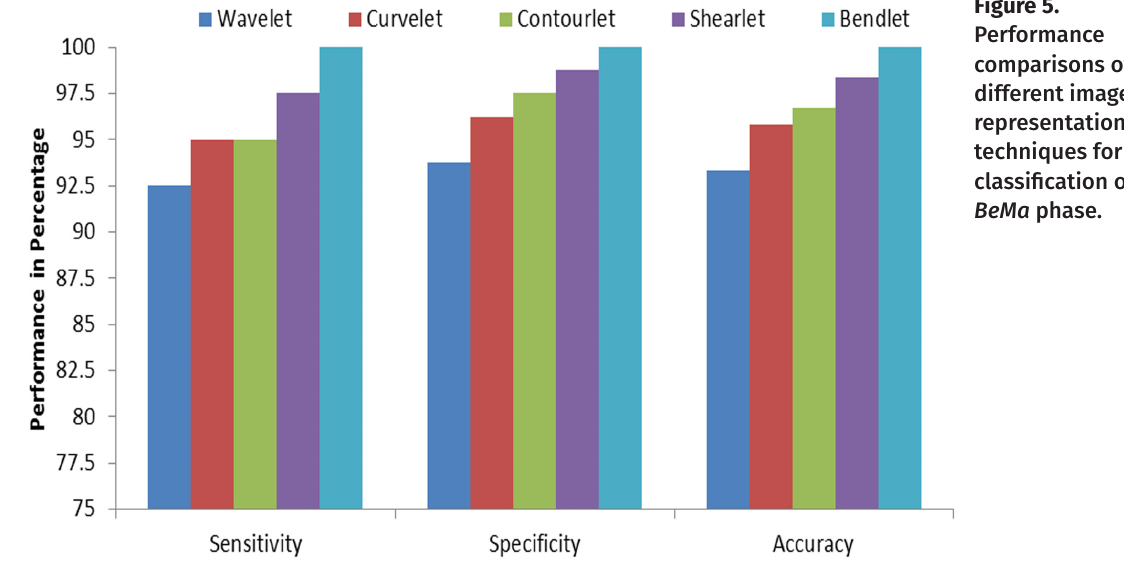
Figure 5. Performance comparisons of different image representation techniques for the classification of BeMa phase.